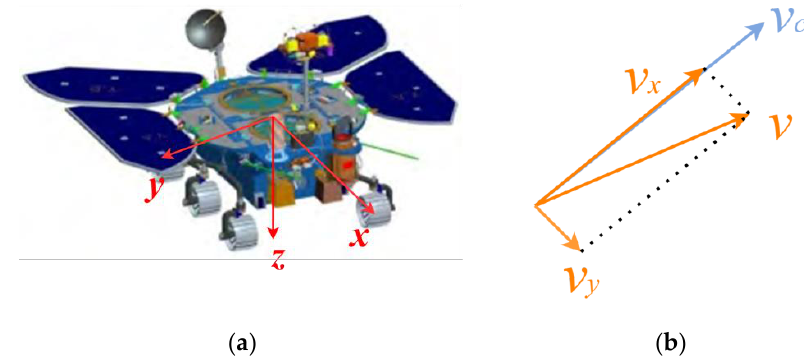
Figure 6. ( a ) The body frame of Zhurong rover; ( b ) velocity decomposition. Table 2. The data collected in ground